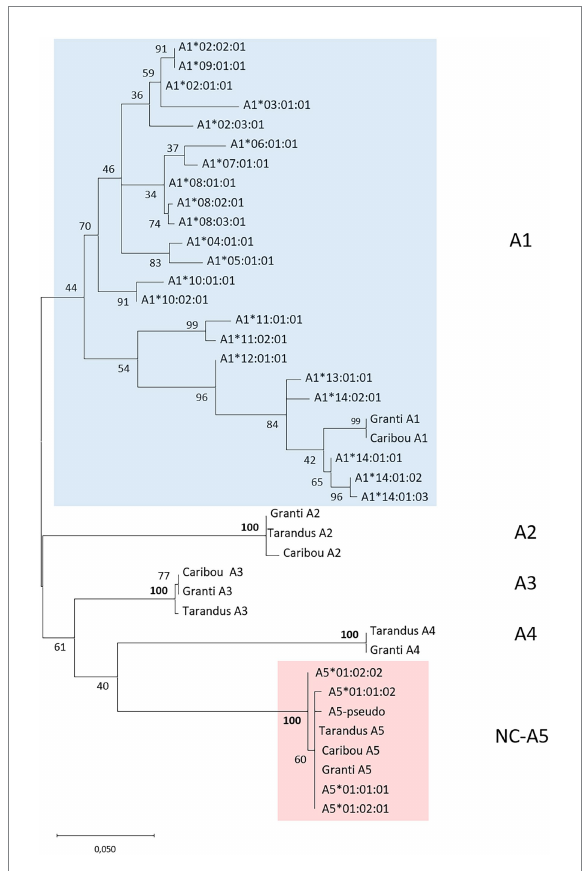
FIGURE 3 Phylogeny of all MHCI sequences. Phylogeny of sequences from both genomic as well as expressed MHCI sequences. Color- coded boxes show clades with A1 and A5 amplicon sequences. The tree with the highest log likelihood (−1762,64) is shown. A discrete Gamma distribution was used to model evolutionary rate differences among sites [5 categories (+ G , parameter = 0,4,620)]. The rate variation model allowed for some sites to be evolutionarily invariable ([+ I ], 35,14% sites). This analysis involved 40 nucleotide sequences with 360 positions in the final dataset. See Supplementary data for sequences and sequence